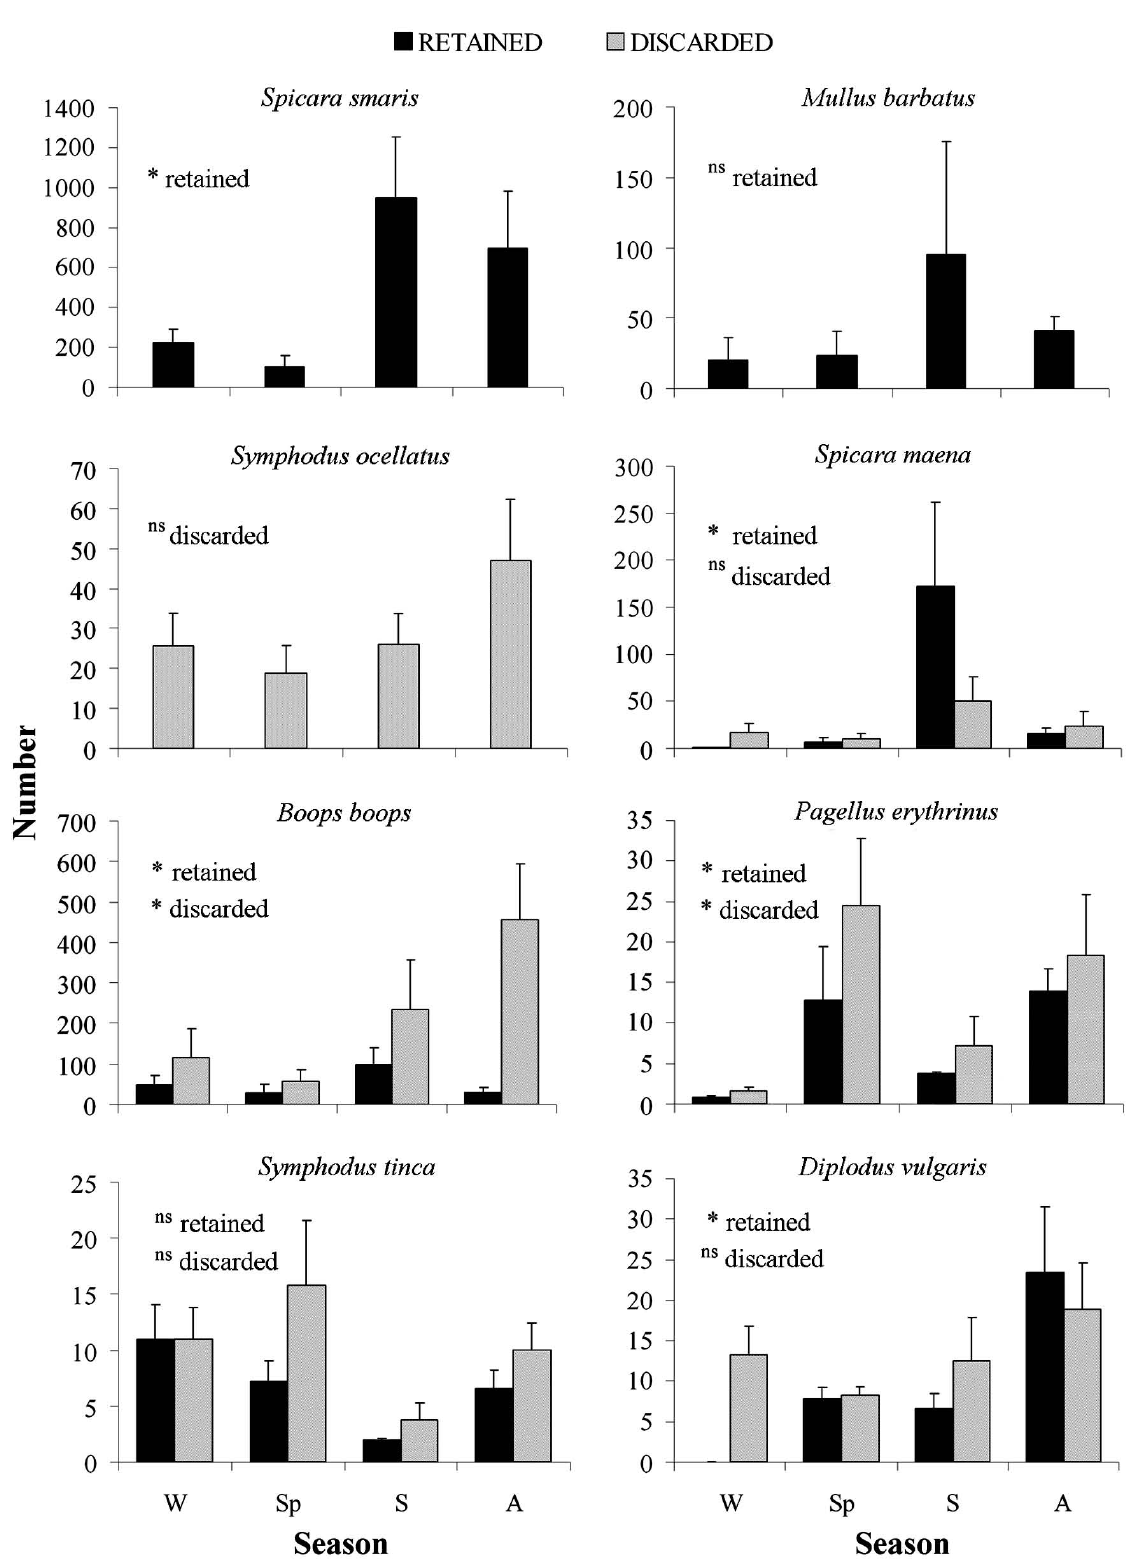
Fig . 7. – Mean values (SE above bars) of retained and discarded catches per haul (CPUE) of individual species in the four different sea- sons. Statistical significance of differences between seasons is indicated on the corresponding graphs by species: * P< 0.05; ns P> 0.05 (not